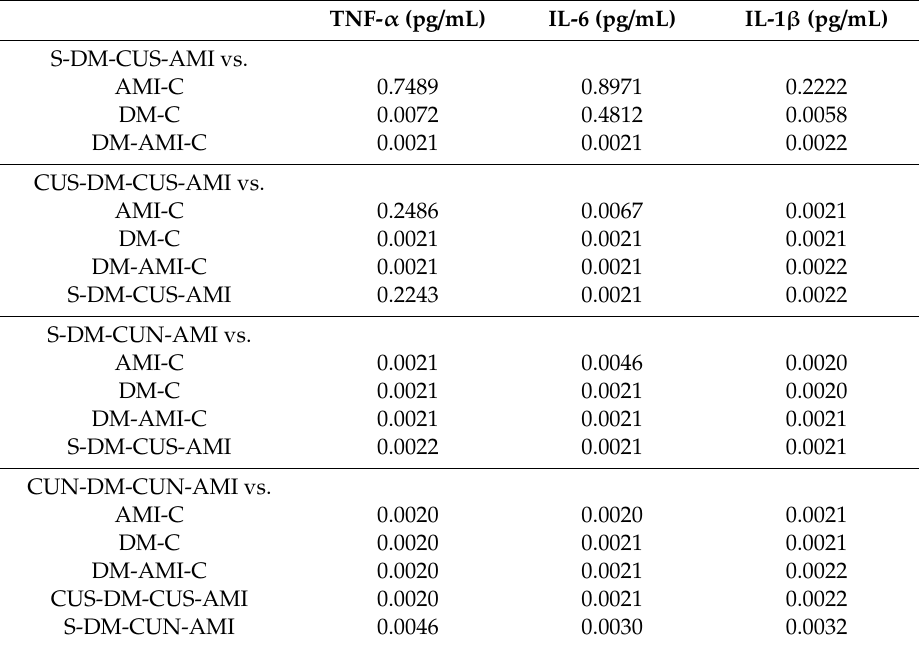
Table 9. P -values for comparisons between the study groups for pro-inflammatory